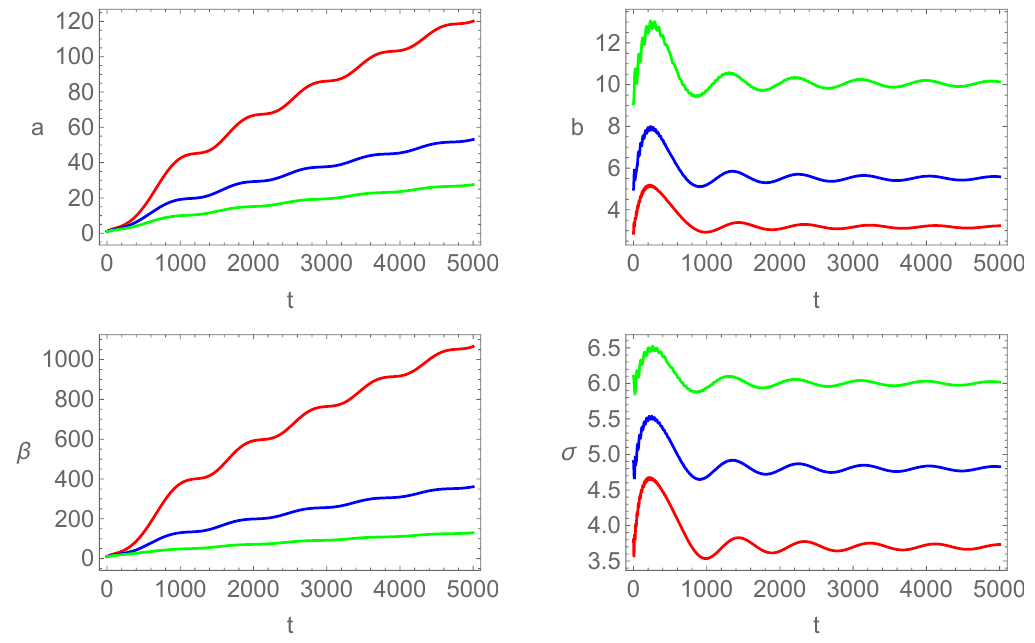
Figure 6. Time evolution of the scale factors { a, b } , the inverse temperature β , and the dilaton σ . The value of σ is chosen from the bottom to the top as σ ∗ = 0 . 001 , 0.003, 0.01, respectively. The other parameters are chosen as (4.7). m 2 b 2 vac